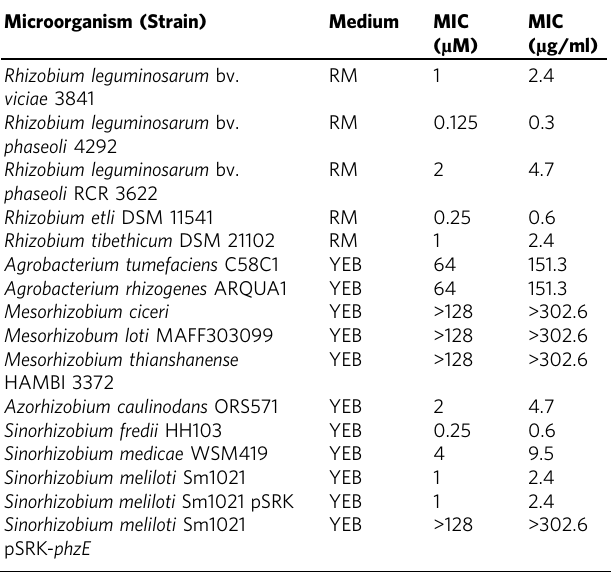
Table 1 Phazolicin MICs for various bacterial strains in rich YEB medium and Rhizobium medium (RM)